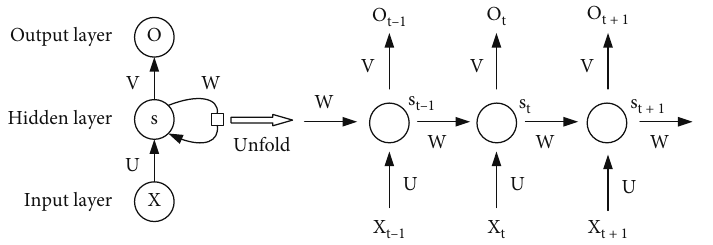
Figure 1: RNN structure